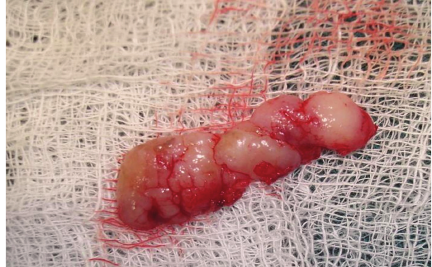
Figure 2: Excision of the enlargement for biopsy with a Nd:YAG laser.